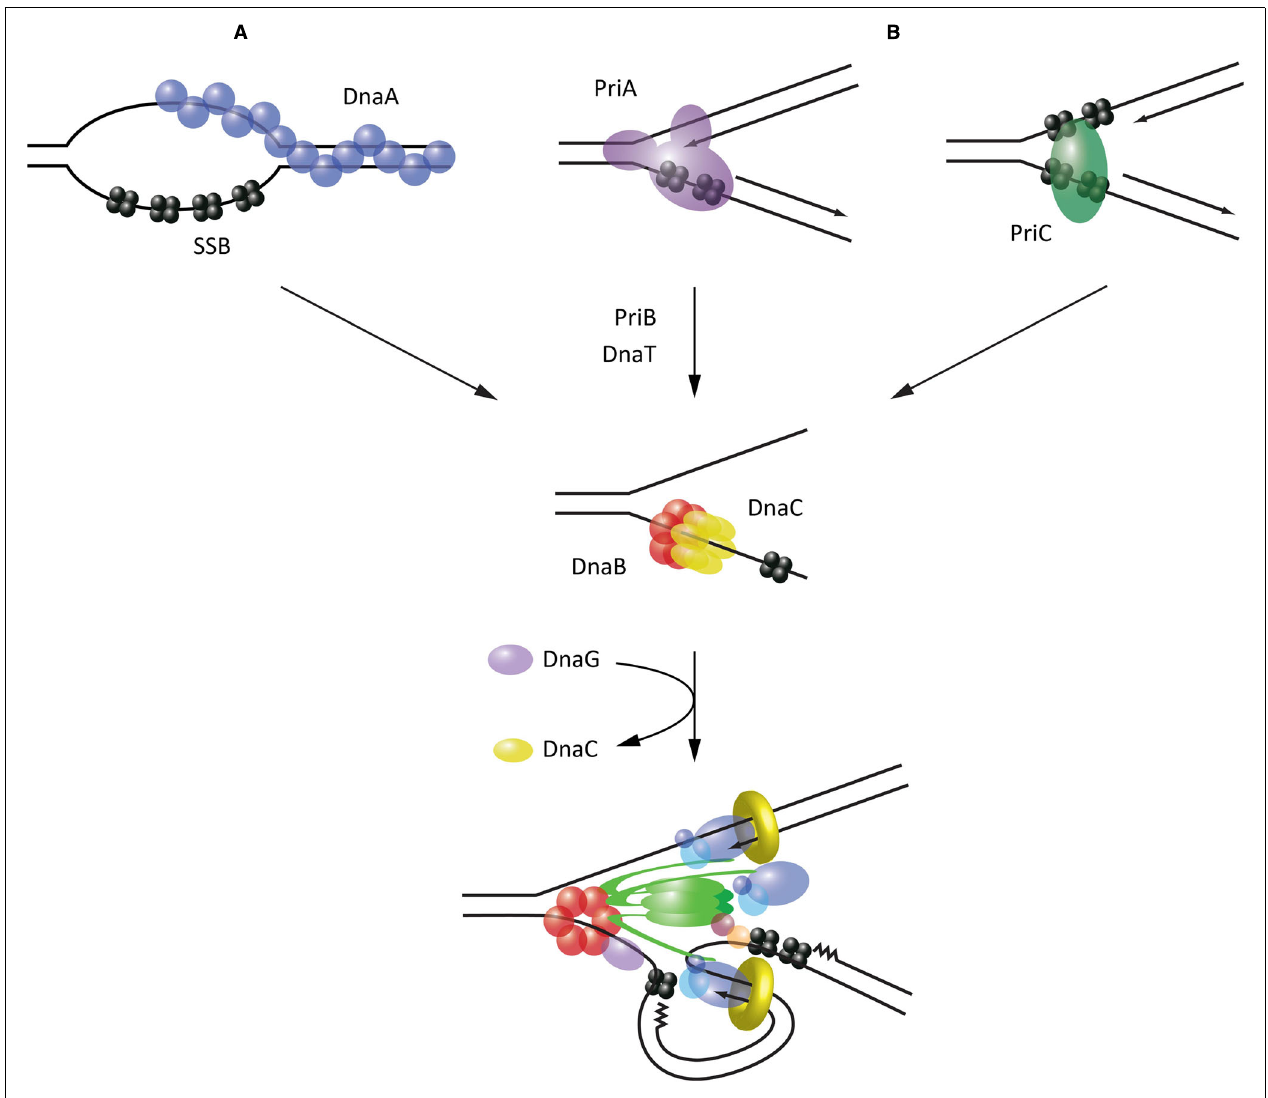
FIGURE 2 | Mechanisms of helicase loading leading to replisome assembly in E. coli . (A) Recognition and melting of the oriC locus during initiation by DnaA. (B) Recognition of abandoned fork structures during